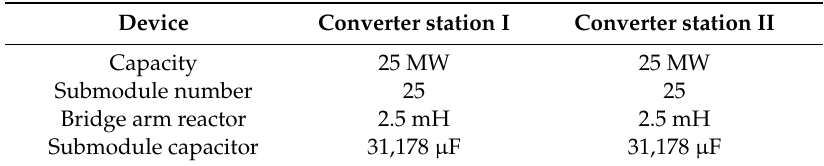
Table 1. Parameters of Main Converters.